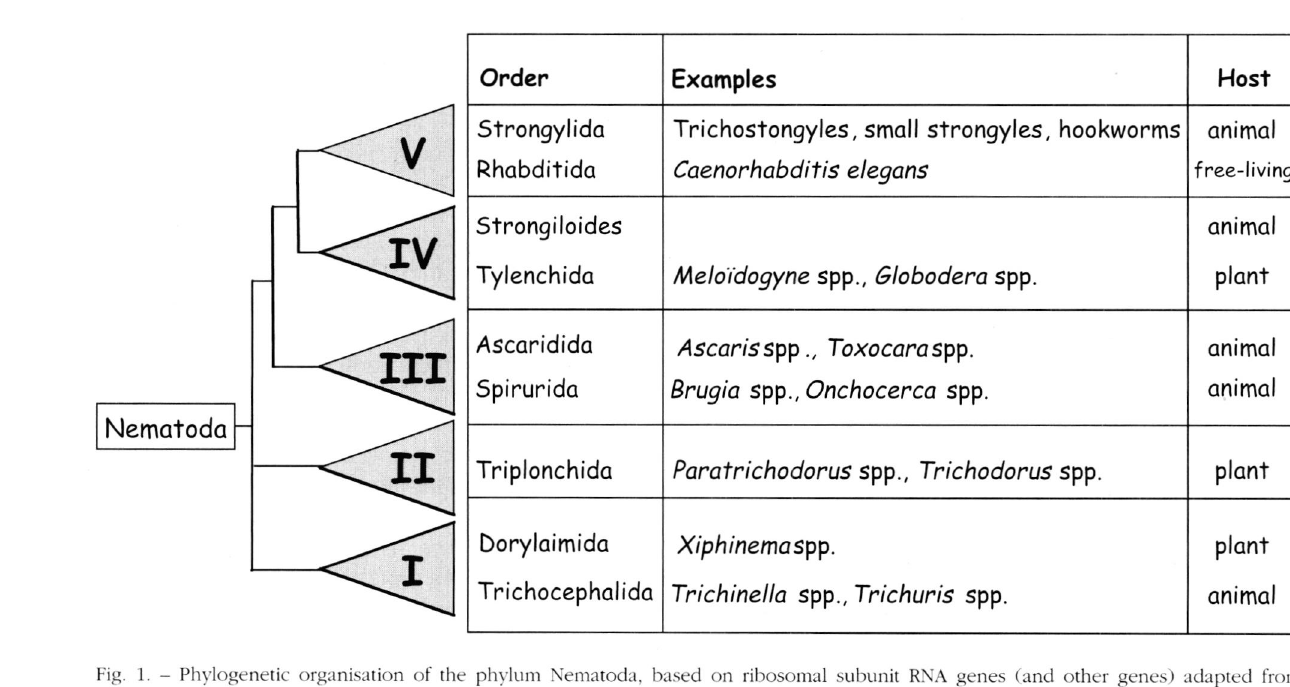
Fig. 1. - Phylogenetic organisation of the phylum Nematoda, based on ribosomal subunit RNA genes (and other genes) adapted from (Blaxter. 1998). Among each clade (1 to 5) orders and species cited in the paper are mentioned.